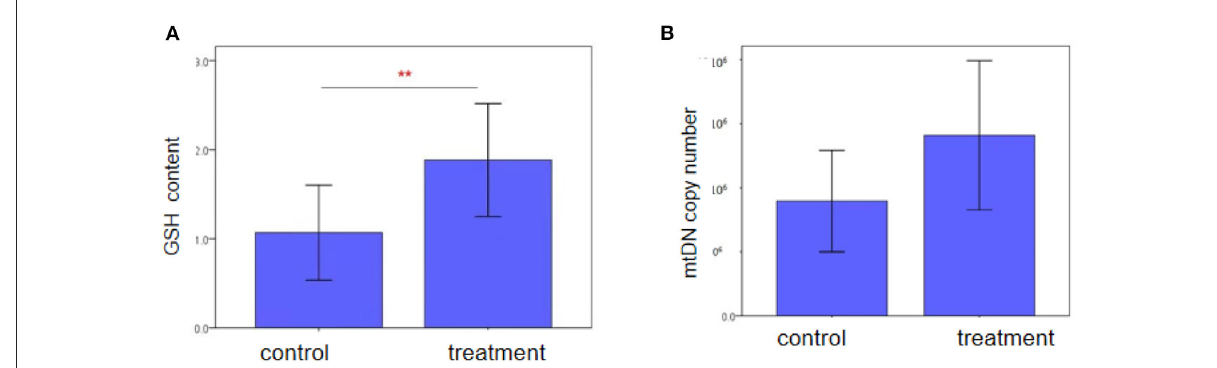
FIGURE2 Intracellular GSH content and mtDNA copy number of granulosa cells in advanced women follicular fluid in the control and treatment groups, as (A) and (B) shown. GSH content in the NAC treatment group was higher than those in the control group ( P < 0.05). Each treatment was repeated 2 times. The data were analyzed with an independent-samples T -test. And mtDNA copy number was similar bwtween two groups ( P >